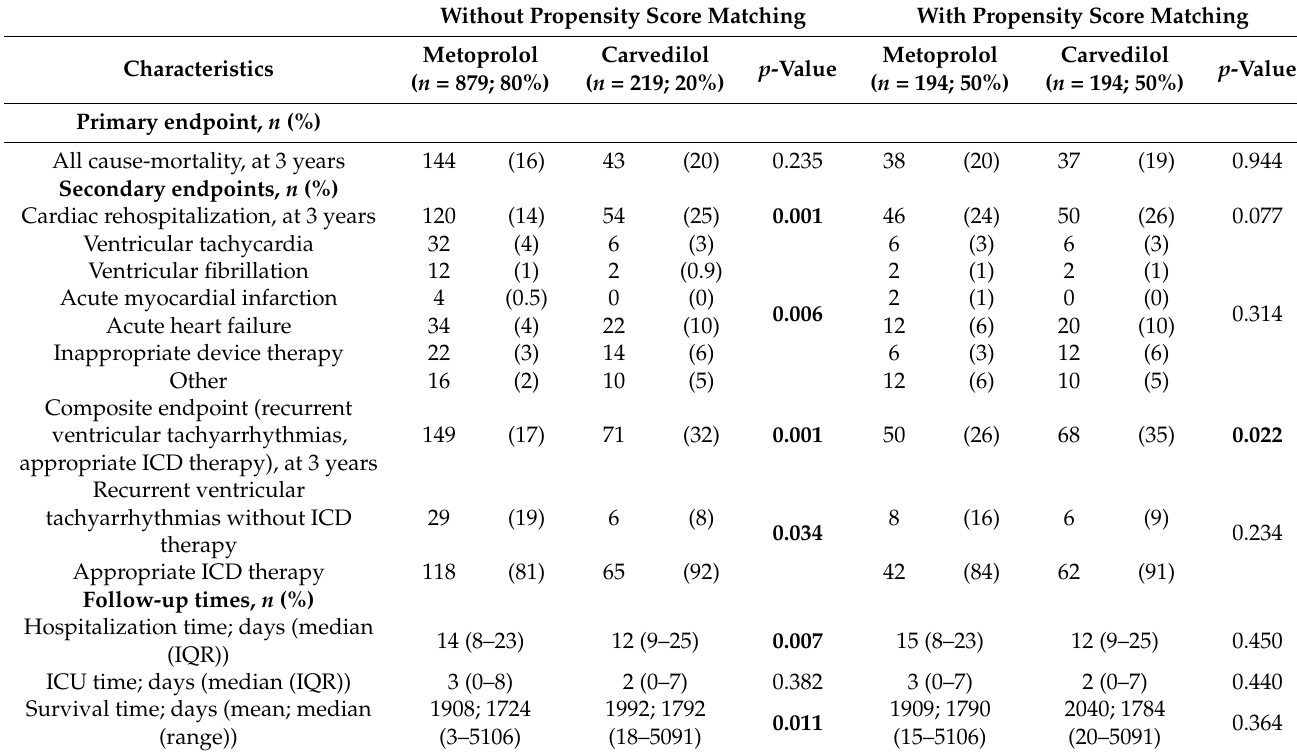
Table 2. Primary and secondary endpoints, follow-up data.